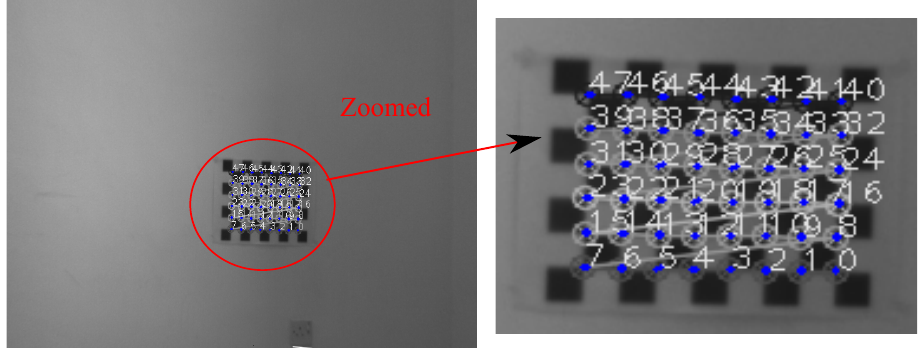
Figure 7. Configuration 1: Reprojection error based on the estimated X and Z matrices. Blue lines indicate the amount of the reprojection error (original image resolution 752 × 480).